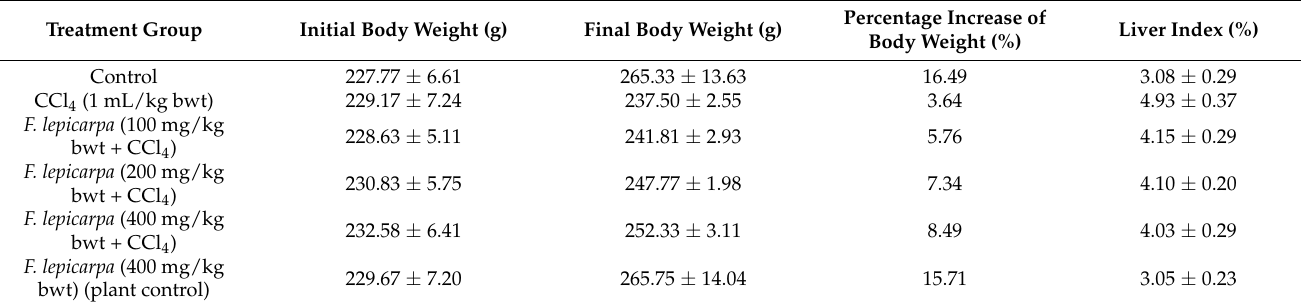
Table 3. Final body weight and liver index of rats in different treatment groups.